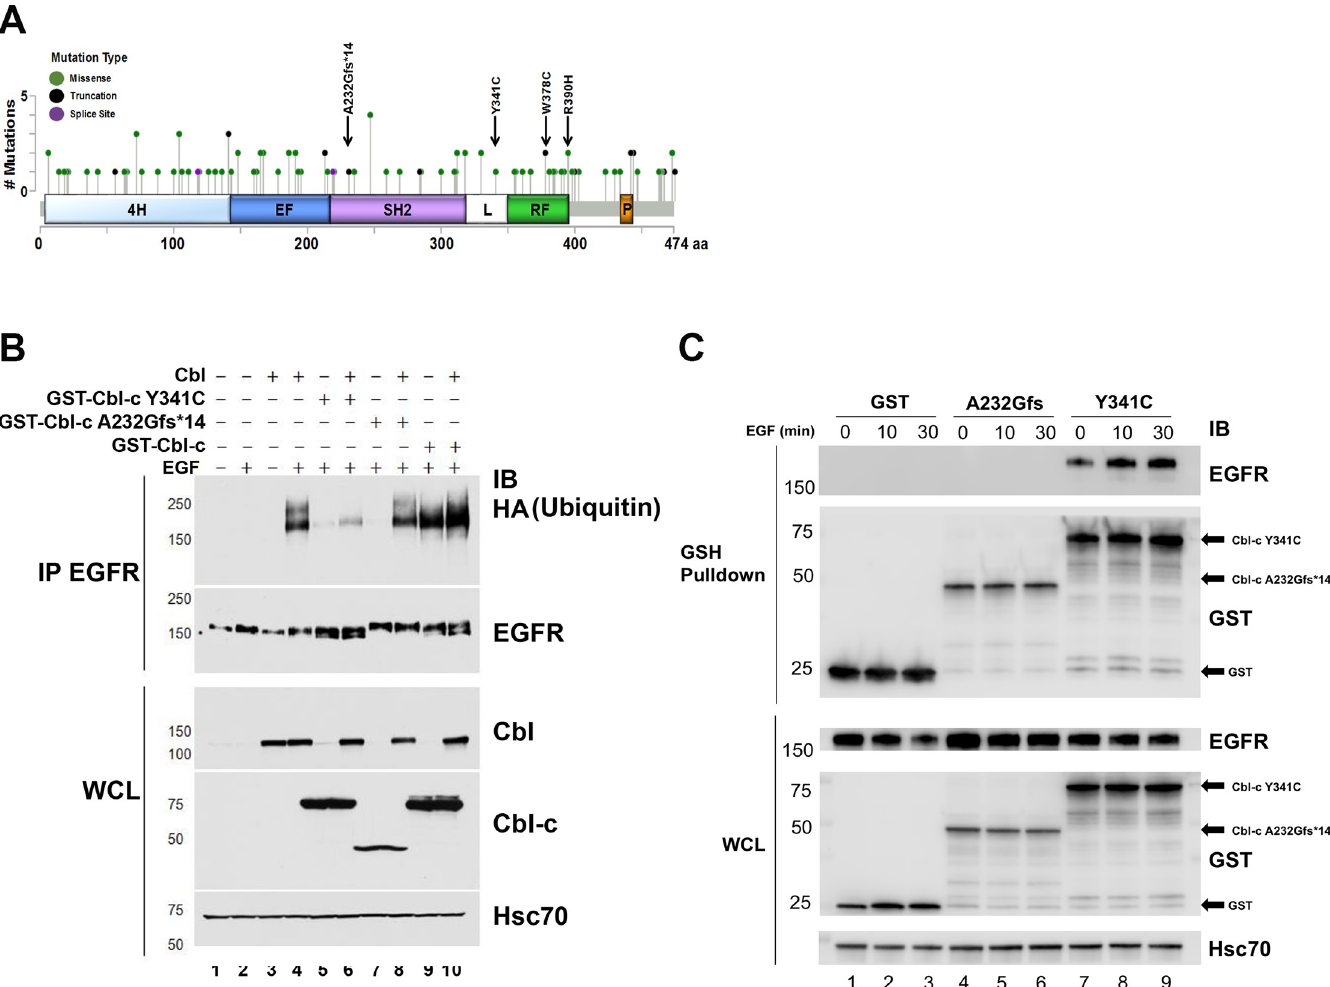
Fig 5. Human Cbl-c mutants Y341C and A232Gfs � 14 demonstrate loss of E3 function. ( A) Cbl-c mutations were identified in the cBioPortal for Cancer Genomics database as indicated in the cartoon. (B) Two mutants identified in lung cancer samples (a frameshift mutant in the TKB domain—A232Gfs � 14, and a point mutation in the linker tyrosine—Y341C) were tested for their ability to ubiquitinate the EGFR. Cells were transfected with various combinations of WT (Cbl and GST-Cbl-c) and mutant (GST-Cbl-c Y341C and GST- Cbl-c A232Gfs � 14) Cbl proteins as indicated. Cells were starved and stimulated with or without EGF for 10 min prior to isolation of protein, immunoprecipitation of EGFR, and gel electrophoresis. IP: EGFR and WCL were immunoblotted for proteins of interest. (C) GST-Cbl-c Y341C, GST-Cbl-c A232Gfs � 14, or GST were cotransfected with the EGFR, the cells were starved and stimulated with EGF for 0, 10 or 30 min prior to protein isolation, and the Cbl-c proteins pulled down using GSH-agarose beads. The GST pull down and WCL lysates were probed as indicated. Molecular weight standards in kDa are indicated on the left of each panel in B and C.